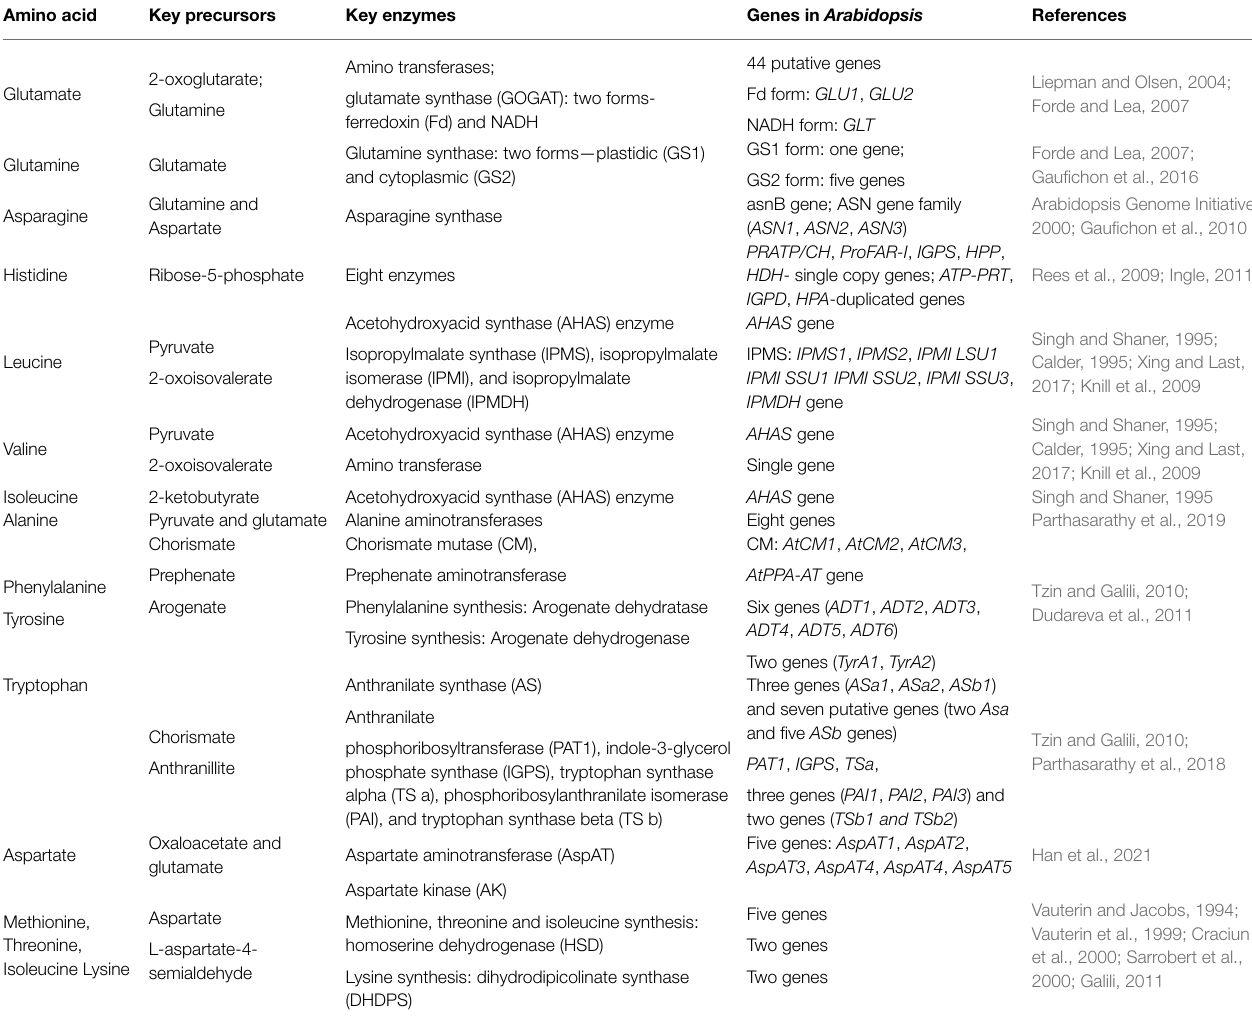
TABLE 4 | Genes responsible for amino acid synthesis. Amino acid Key